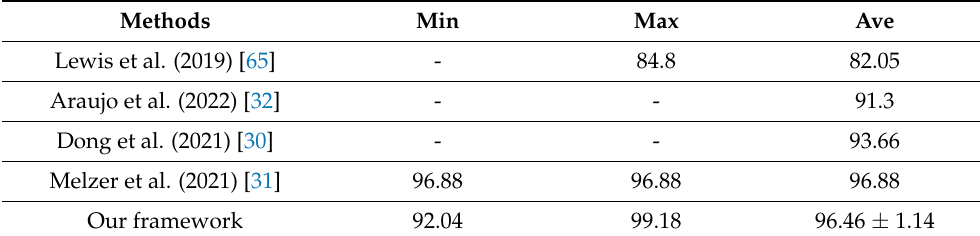
Table 9. Training Scenario I: comparisons with other methods